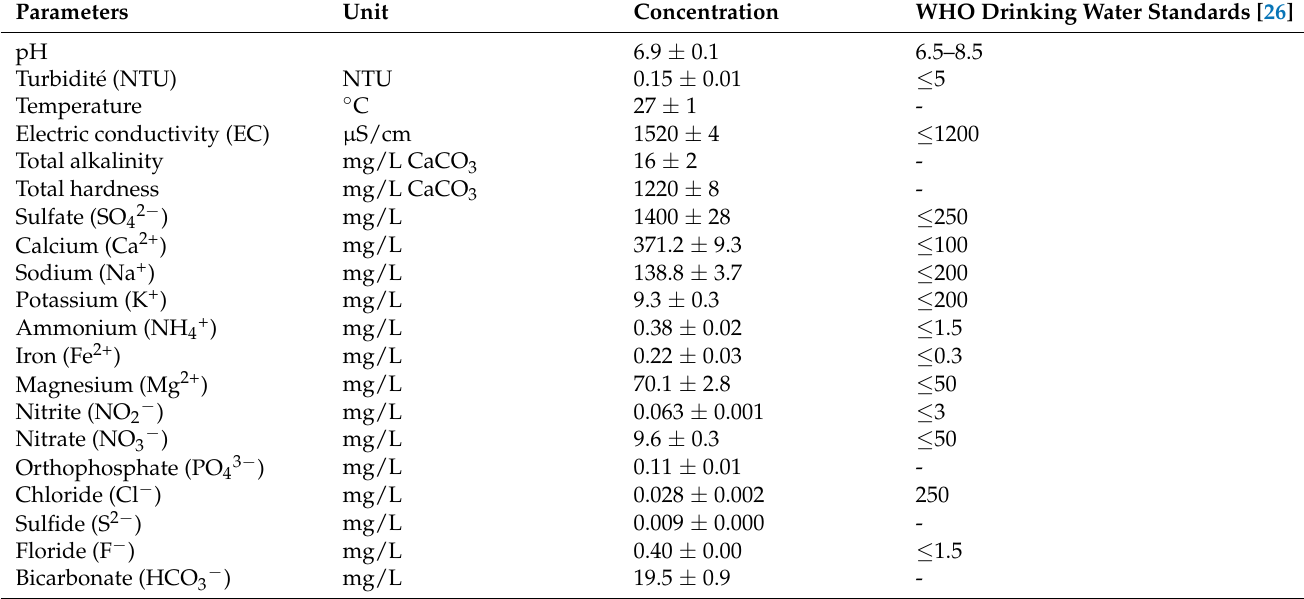
Table 2. Characteristics of Garp é n é ’s borehole